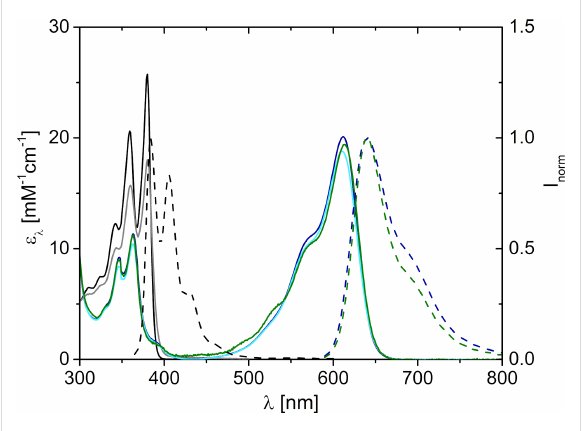
Figure 1: Optical properties of NDI 1 and cNDIs 2 and 6 : UV–vis ab- sorbance in CH 2 Cl 2 and in DMF (normal lines), normalized fluores- cence in CH 2 Cl 2 (dashed lines); 1 in CH 2 Cl 2 (black), 1 in DMF (gray), 2 in CH 2 Cl 2 (green), 6 in CH 2 Cl 2 (dark blue), 6 in DMF (light blue), l exc = 350 nm for 1 , λ exc = 600 nm for 2 and 6